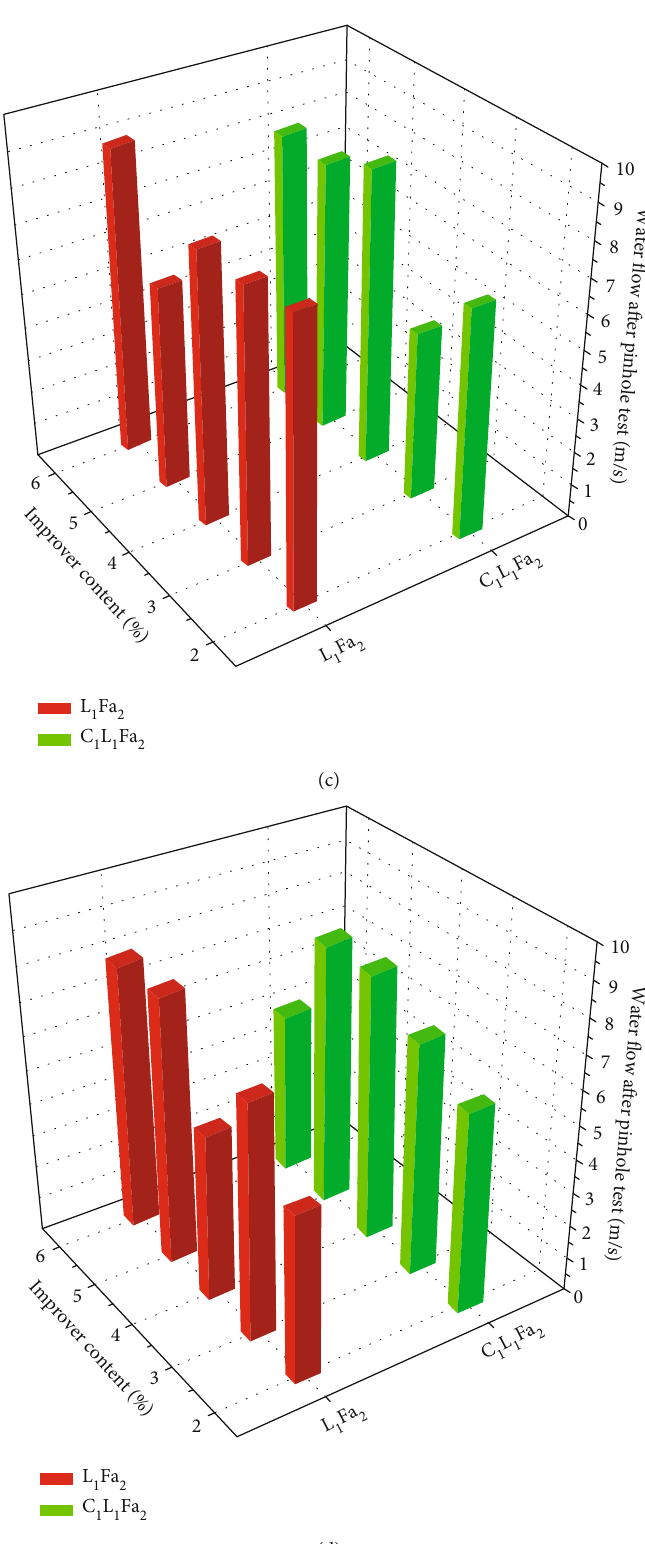
Figure 13: Results of the addition of two types of improvement measures (L improved transitional soil; (b) fragmentation test of the improved dispersive soil; (c) pinhole test of the improved transitional soil; (d) pinhole test of the improved dispersive